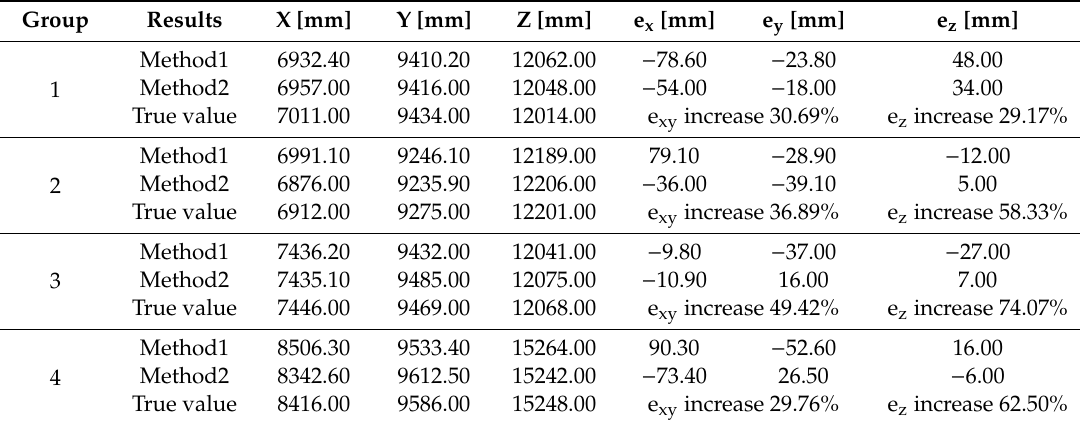
Table 2. The results and errors of the spatial positions.